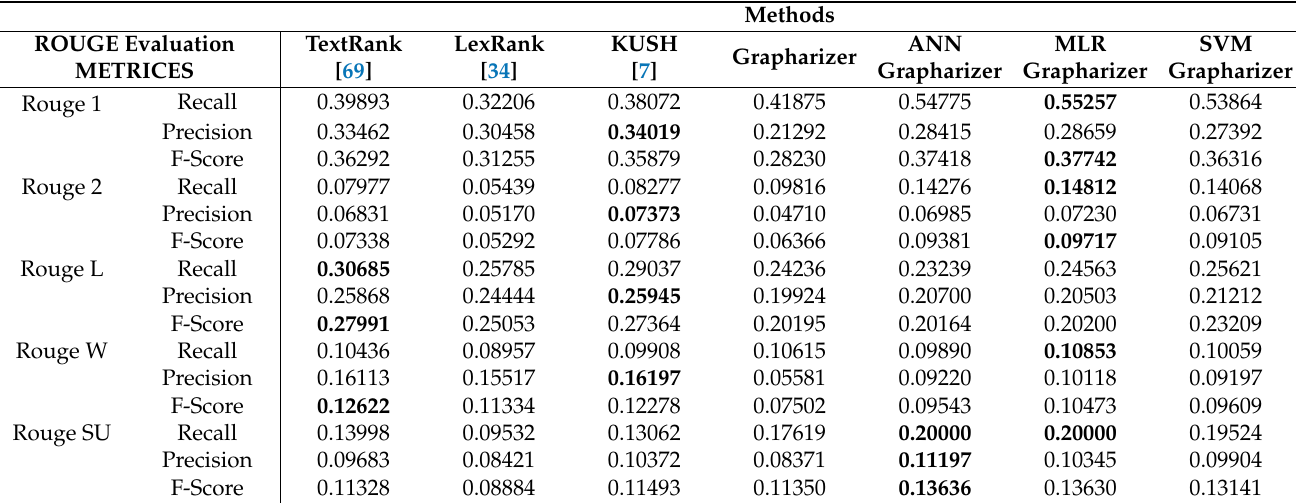
Table 3. Comparison of Grapharizer with State-Of-The-Art Graph-Based Methods.